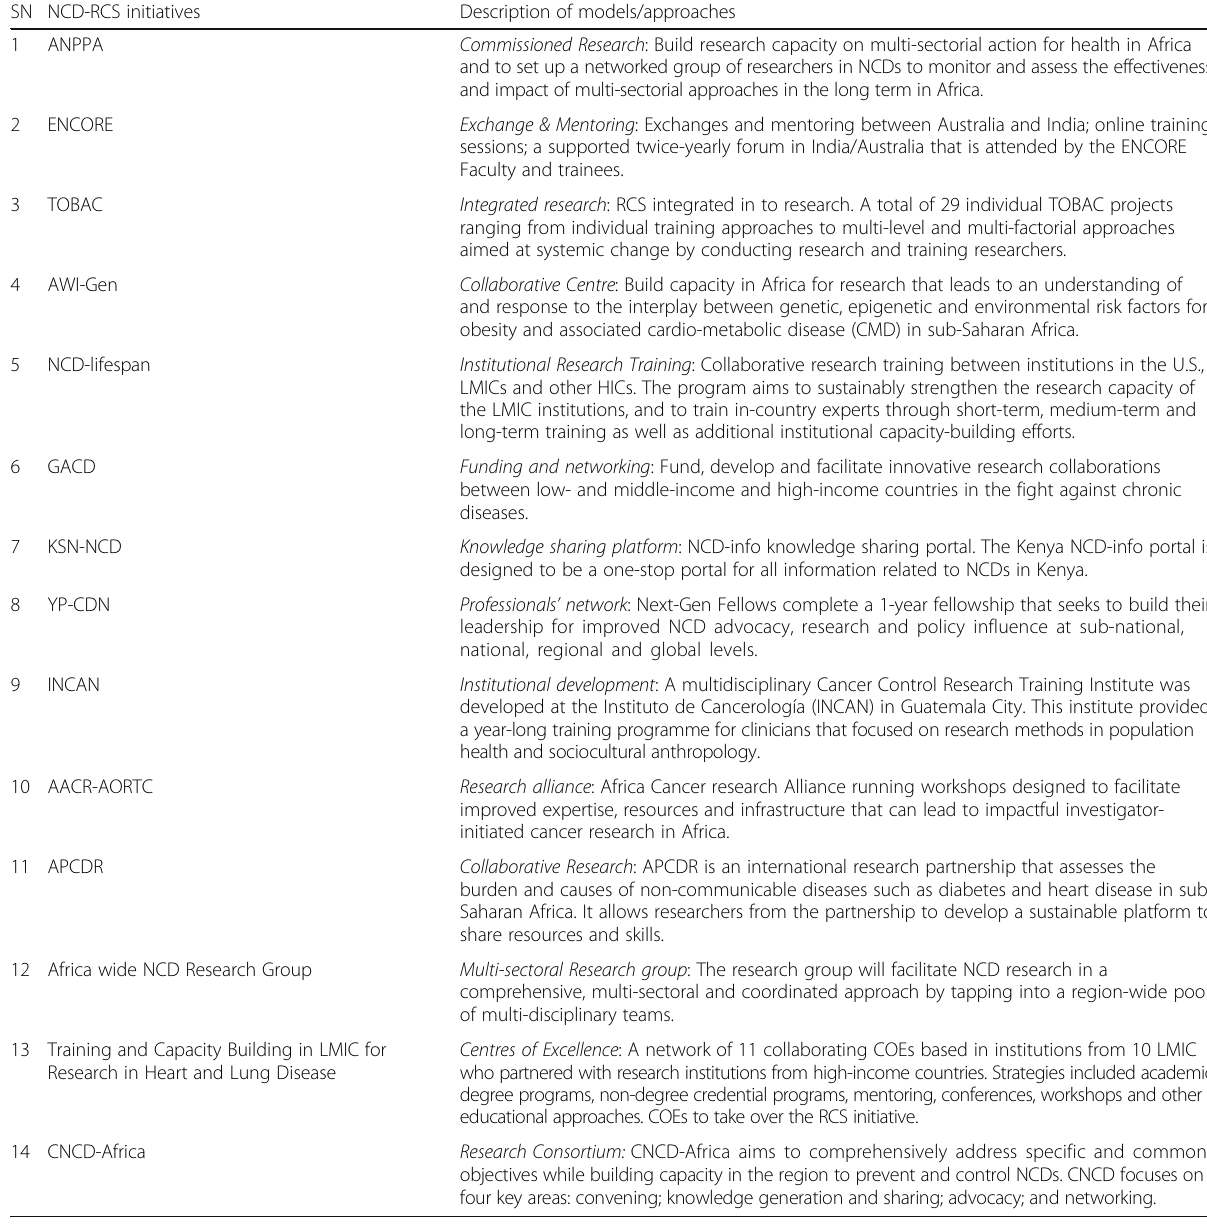
Table 3 Description by example of the approaches used by the selected NCD-RCS initiatives SN NCD-RCS